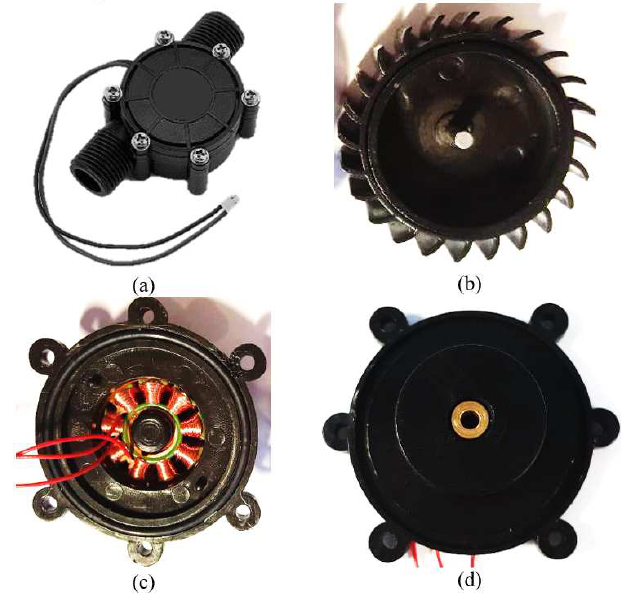
Figure 4. ( a ) outlook of the water turbine generator; ( b ) rotor; ( c ) stator and its corresponding wire windings as nine coils; ( d ) rotor